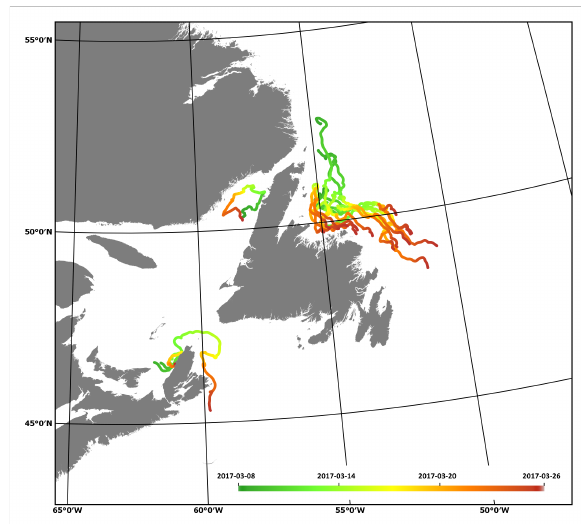
Figure 3. Movement of satellite-linked GPS transmitters deployed in whelping concentrations to monitor ice movement during the March 2017 Harp Seal survey.